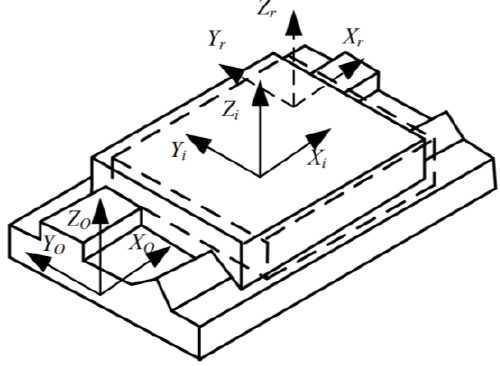
Figure 4. Schematic diagram of coordinate system.